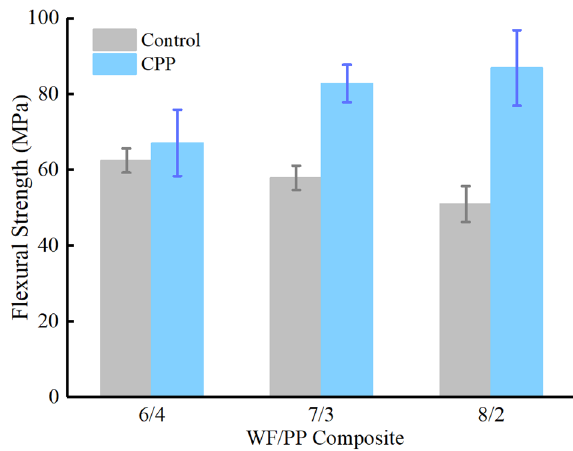
Figure 11. The flexural strength properties of the WF/PP composites.